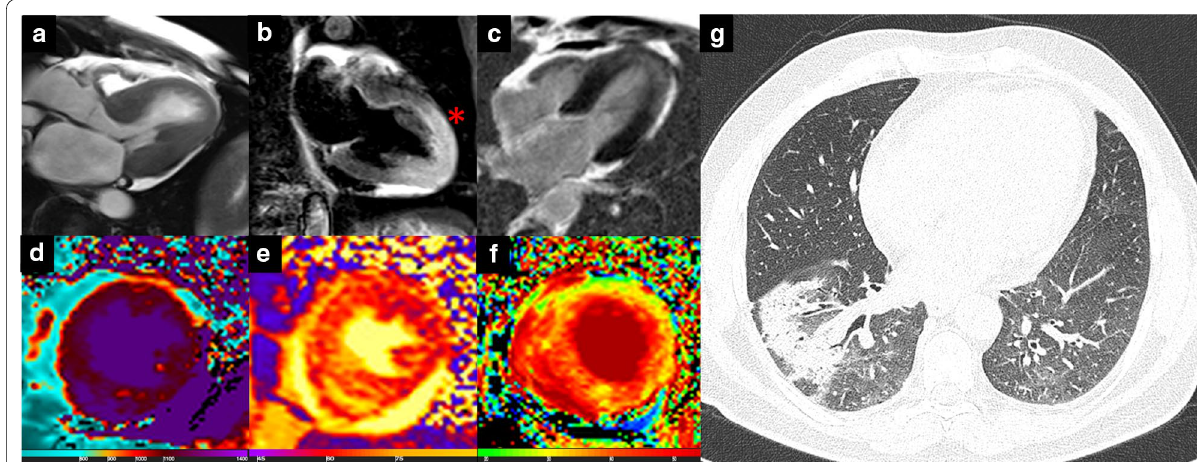
Fig. 6 Takotsubo cardiomyopathy. COVID-19 female patient with chest pain and no CAD. Cine-SSFP showed a diffuse hypokinesia of mid and apical segments with «apical ballooning» sign ( a ). Diffuse edema of mid-ventricular and apical segments on 2-chambers STIR was found ( b red asterisk). PSIR sequences evidenced no LGE ( c) . Native T1, T2 mapping and ECV fraction values were all increased ( d – f ). Chest CT showed a low-grade pulmonary involvement with peripheral interstitial thickening ( g ). CAD coronary artery disease; SSFP steady-state free precession; STIR short tau inversion recovery; PSIR phase sensitive inversion recovery; LGE late gadolinium enhancement; ECV extracellular volume; CT computed